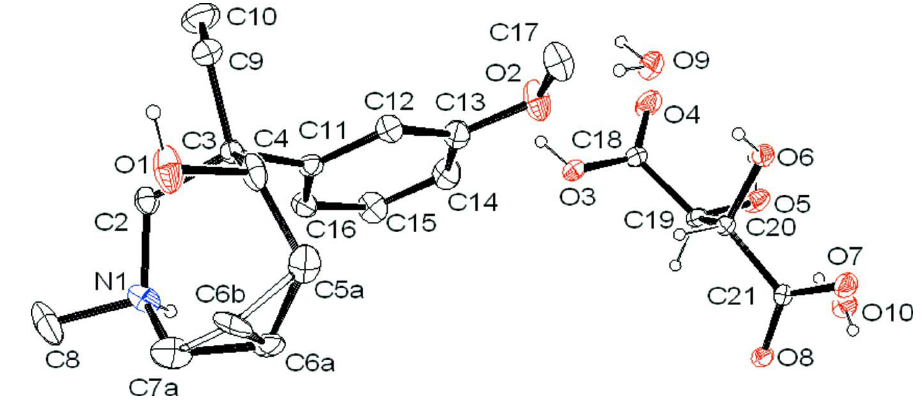
Figure 1 The molecular structure of the title compound, showing displacement ellipsoids at the 20% probability level. Hydrogen atoms are shown as spheres of arbitrary radius. Both azepane ring conformations are depicted; the minor chair conformation is drawn with open bonds. H atoms bonded to the C atoms of the azepane unit have been omitted for clarity.